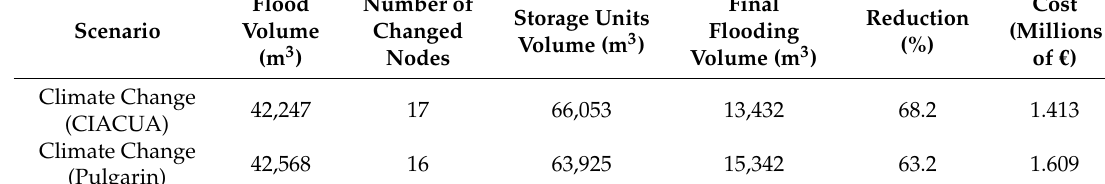
Table 2. Results for the Southern Chicó Network using OptSU under Climate Change scenarios.